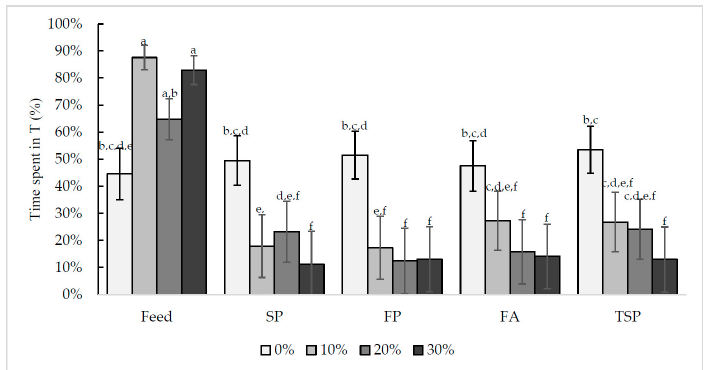
Figure 6. Effect of door weight (0%, 10%, 20%, or 30% of chicks’ body weight) and resource (feed, soiled pine and spruce wood shavings (SP), fresh pine and spruce wood shavings (FP), fresh aspen wood shavings (FA), ammonia reductant treated soiled pine and spruce wood shavings (TSP)) on the mean time spent (%) in the treatment (T) compartment for 13.5 h per day. Bars with di ff erent letters display significant di ff erences ( p <